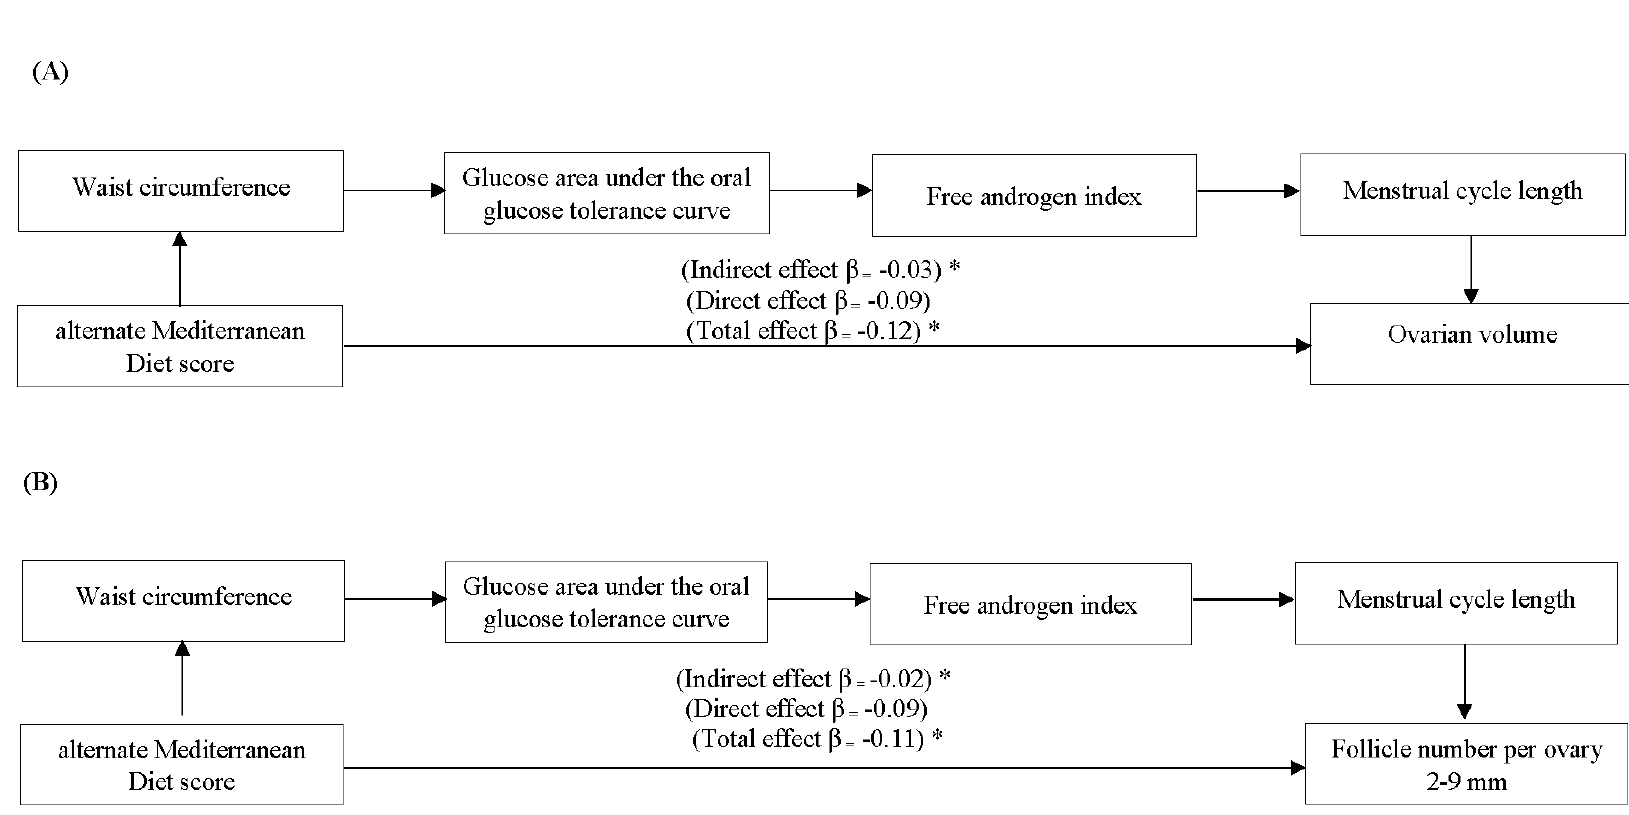
Figure 3. Serial mediation analyses demonstrating indirect associations between aMED score and ovarian characteristics on ultrasonography for n = 109 women who provided optimal image quality with a reliable evaluation of ovarian volume ( Panel A ) and follicle number per ovary ( Panel B ). β is a standardized product of serial regression models on log-transformed variables. Standardized β can be interpreted as the expected standard deviation (SD) change in the OV and FNPO per 1 SD increase in dietary patterns through serial mediators. Waist circumference was selected as a proxy for obesity; total glucose area under the 75 g oral glucose tolerance test curve for insulin resistance; free androgen index for hyperandrogenism; and menstrual cycle length for oligo-anovulation based on the magnitude of the effect estimates demonstrated in our statistical models shown in Supplementary data 2 (Supplementary Tables 1 and 2). All models are adjusted for age, race, and total energy intake. An asterisk above the effect estimate denotes a significant effect estimate ( p < 0.05).